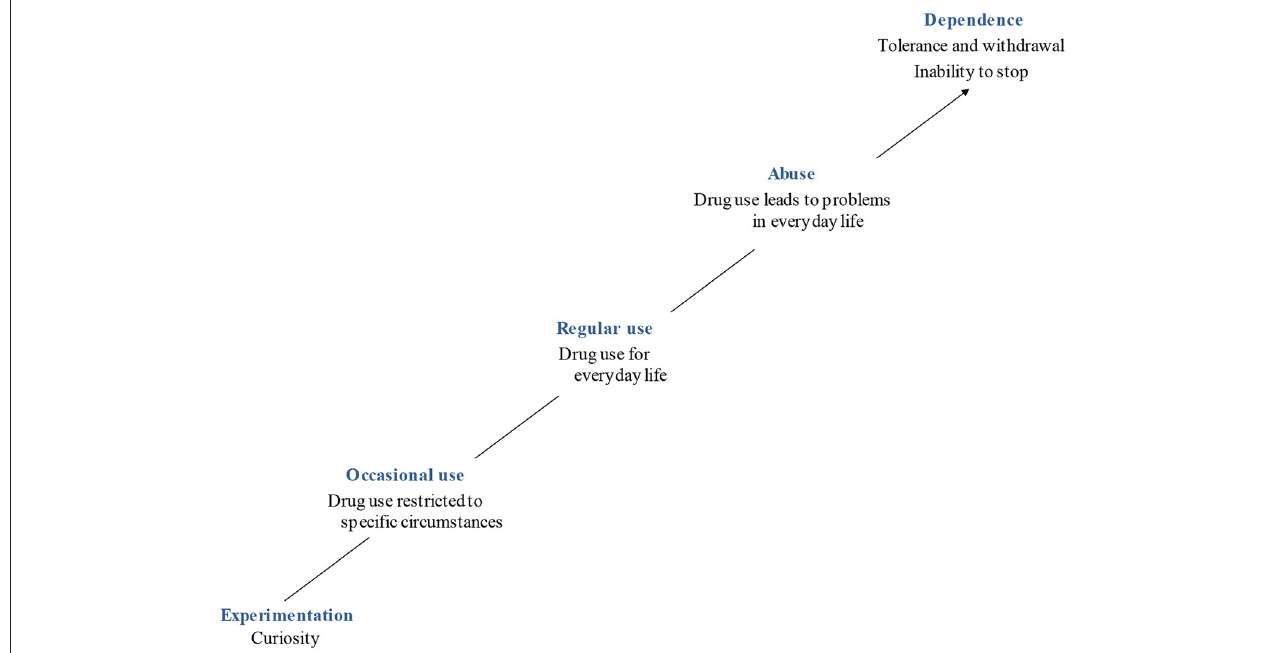
FIGURE 1 | From drug use to the risk of